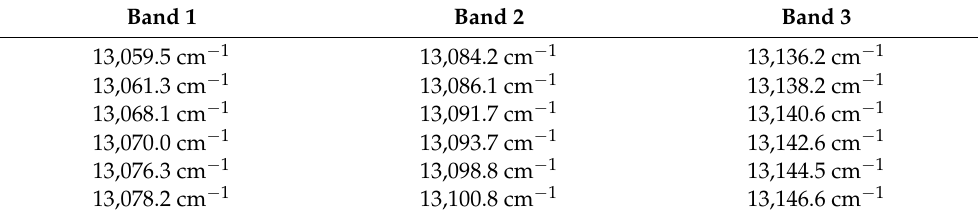
Table 1. Pre-selection of observation band and containing emission